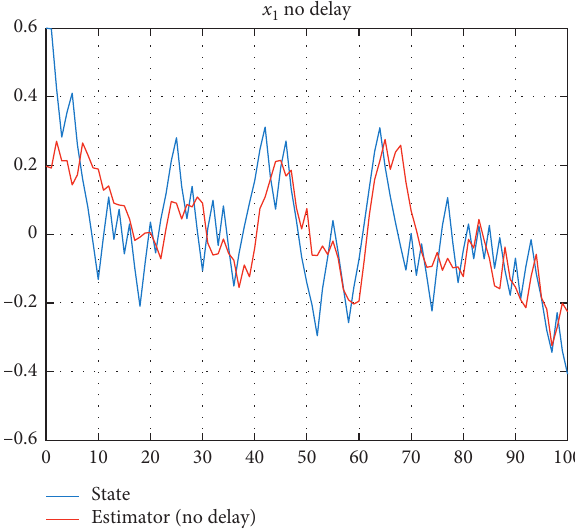
Figure 3: The first state component x